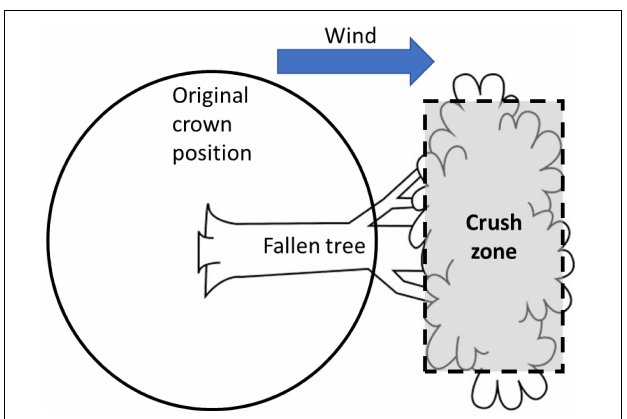
FIGURE 3 | Schematic illustration of the estimation of neighbor support. Smaller solid circle depicts original position of the focal tree, and dotted circle depicts lateral displacement of crown due to wind. Vertical grey arrow illustrates the amount of crown overlap between focal three and neighbor tree.